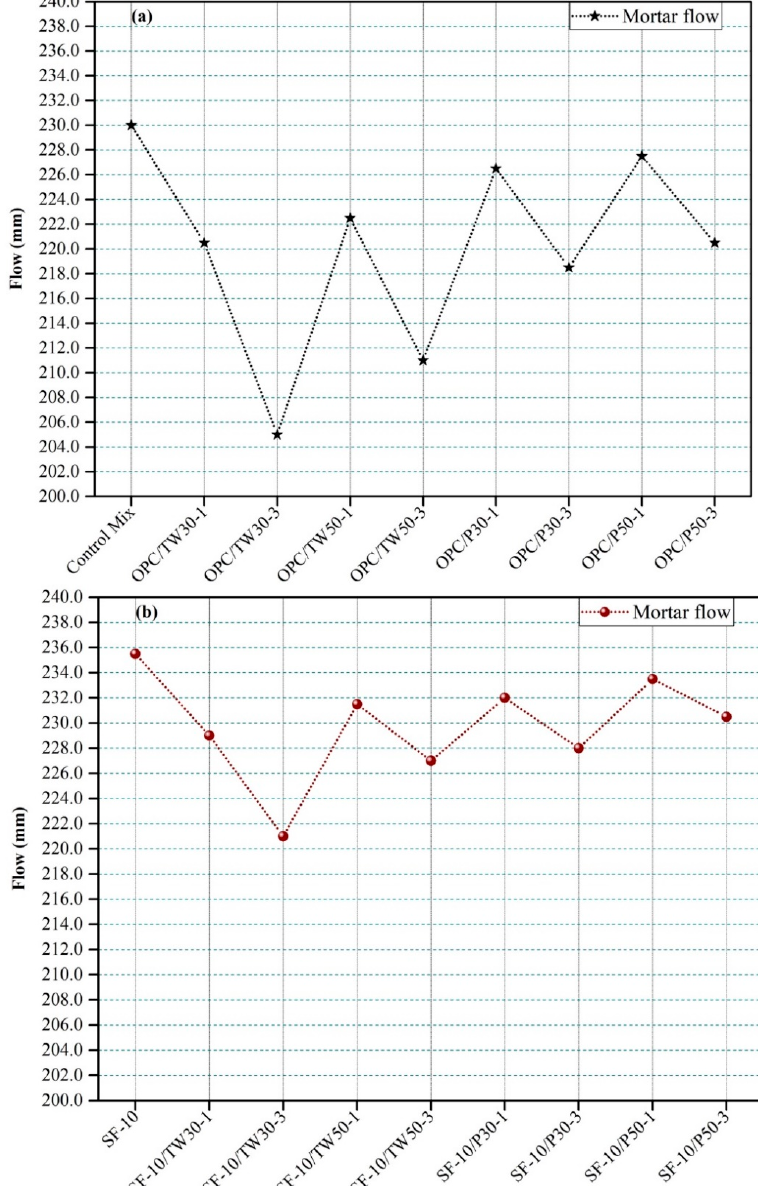
Figure 1. Flow of mortars made with tea waste and perlite particles. ( a ) 100% OPC and ( b ) 90% OPC and 10% SF.